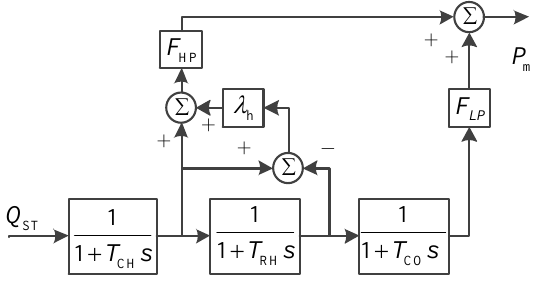
Figure 3. System diagram of steam turbine module. F HP and F LP are the proportional coefficients of high-pressure cylinder and low-pressure cylinder, respectively. λ h is the overshooting coefficient. T CH , T RH and T CO are the volume time constants.